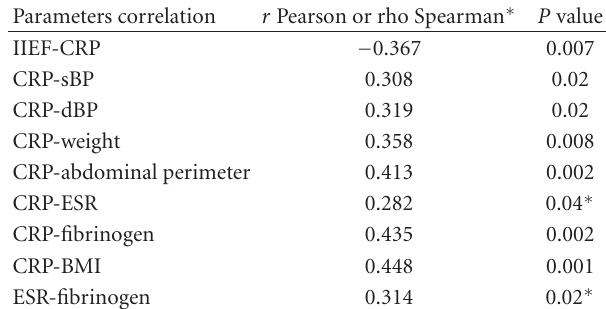
IIEF: International Index Erectile Function; sBP: systolic Blood Pressure; dBP: diastolic Blood Pressure; CRP: C-Reactive Protein; ESR: Erythrocyte Sedimentation Rate. Table 6: Multiple linear regression analysis of independent